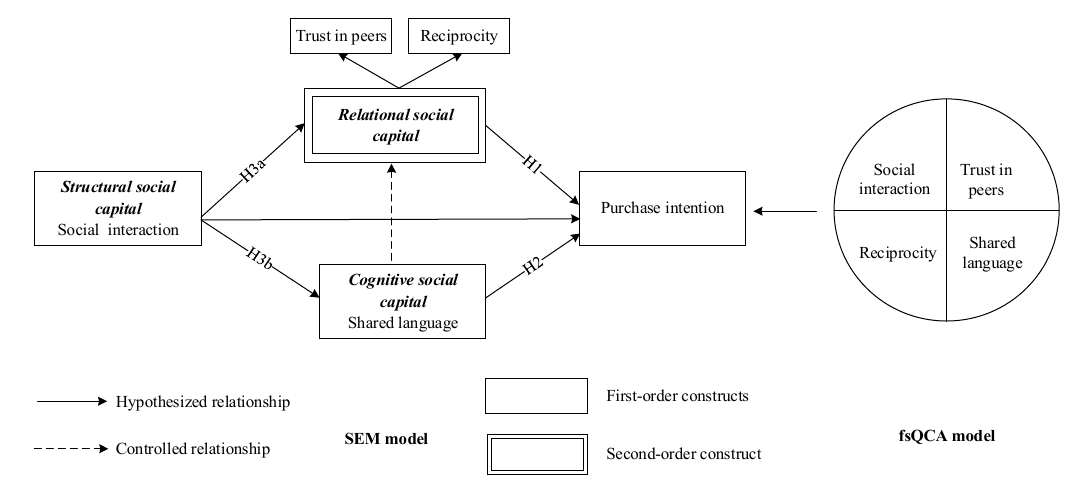
Figure 1. Conceptual model.